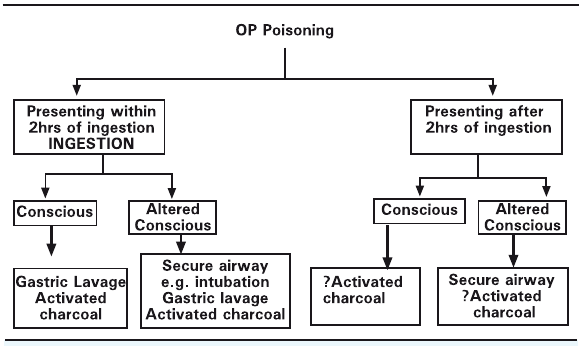
Figure 2. Decontamination Procedure in OP Poisoning Specific Antidotal